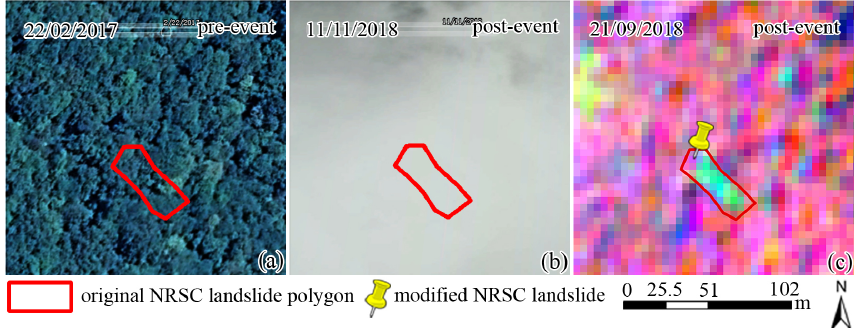
Figure 10. Example of the obstruction of view by clouds in which the original NRSC landslide polygons could not be checked: (a) pre- landslide Google Earth image, (b) earliest available post-landslide Google Earth image in which the landslide cannot be recognized, and (c) mapping of the landslide initiation point based on Resourcesat-2 LISS-IV image (RGB combination: near infrared, red, green). Basemap data for (a) and (b) © Google Earth 2019.